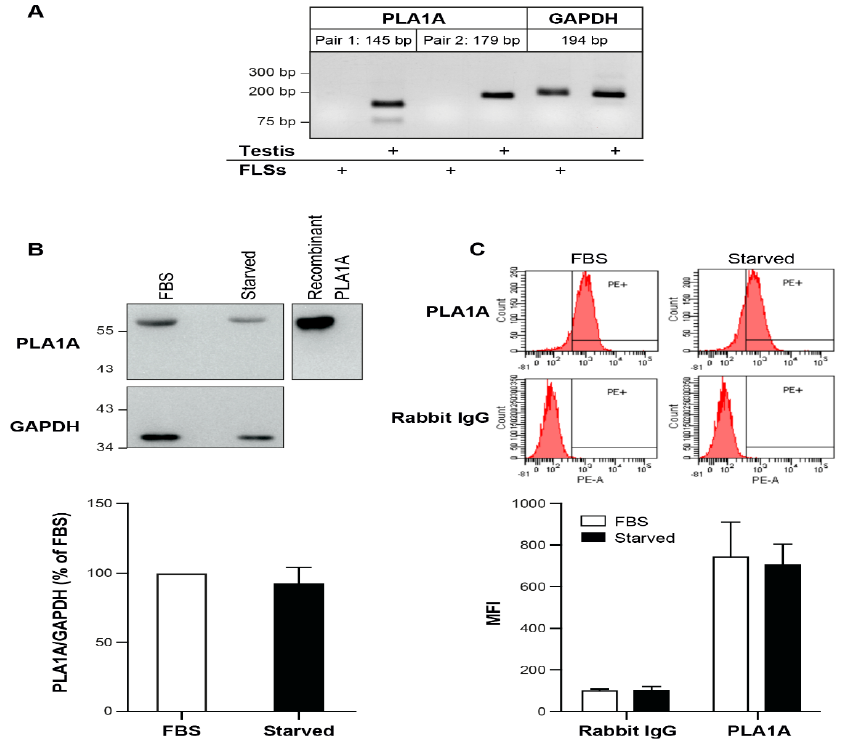
Figure 2. Presence of PLA1A in cultured human primary FLSs. ( A ) Total RNA from human primary FLSs from normal donors were tested for the expression of PLA1A by semi-quantitative RT-PCR. Two pairs PLA1A oligo primers were tested. GAPDH was used as a house-keeping gene. Total RNA from human testis tissue was used as a positive control. ( B ) The presence of PLA1A in human primary FLSs cultured in the absence or presence of 10% FBS were examined using western blot. GAPDH was used as an internal loading control. Recombinant PLA1A protein was used as a positive control. The blots shown are representative of five independent experiments with similar results. Amount of PLA1A was quantified densitometrically and was normalized with respect to total GAPDH. The data were the means ± SE from five experiments. ( C ) The presence of PLA1A in human primary FLSs cultured in the absence or presence of 10% FBS were examined using flow cytometry. Cells were permeabilized with digitonin, and rabbit IgG isotype was used as a control. The figures shown were representative of three independent experiments with similar results. The data were the means ± SE from three experiments. MFI, mean fluorescence